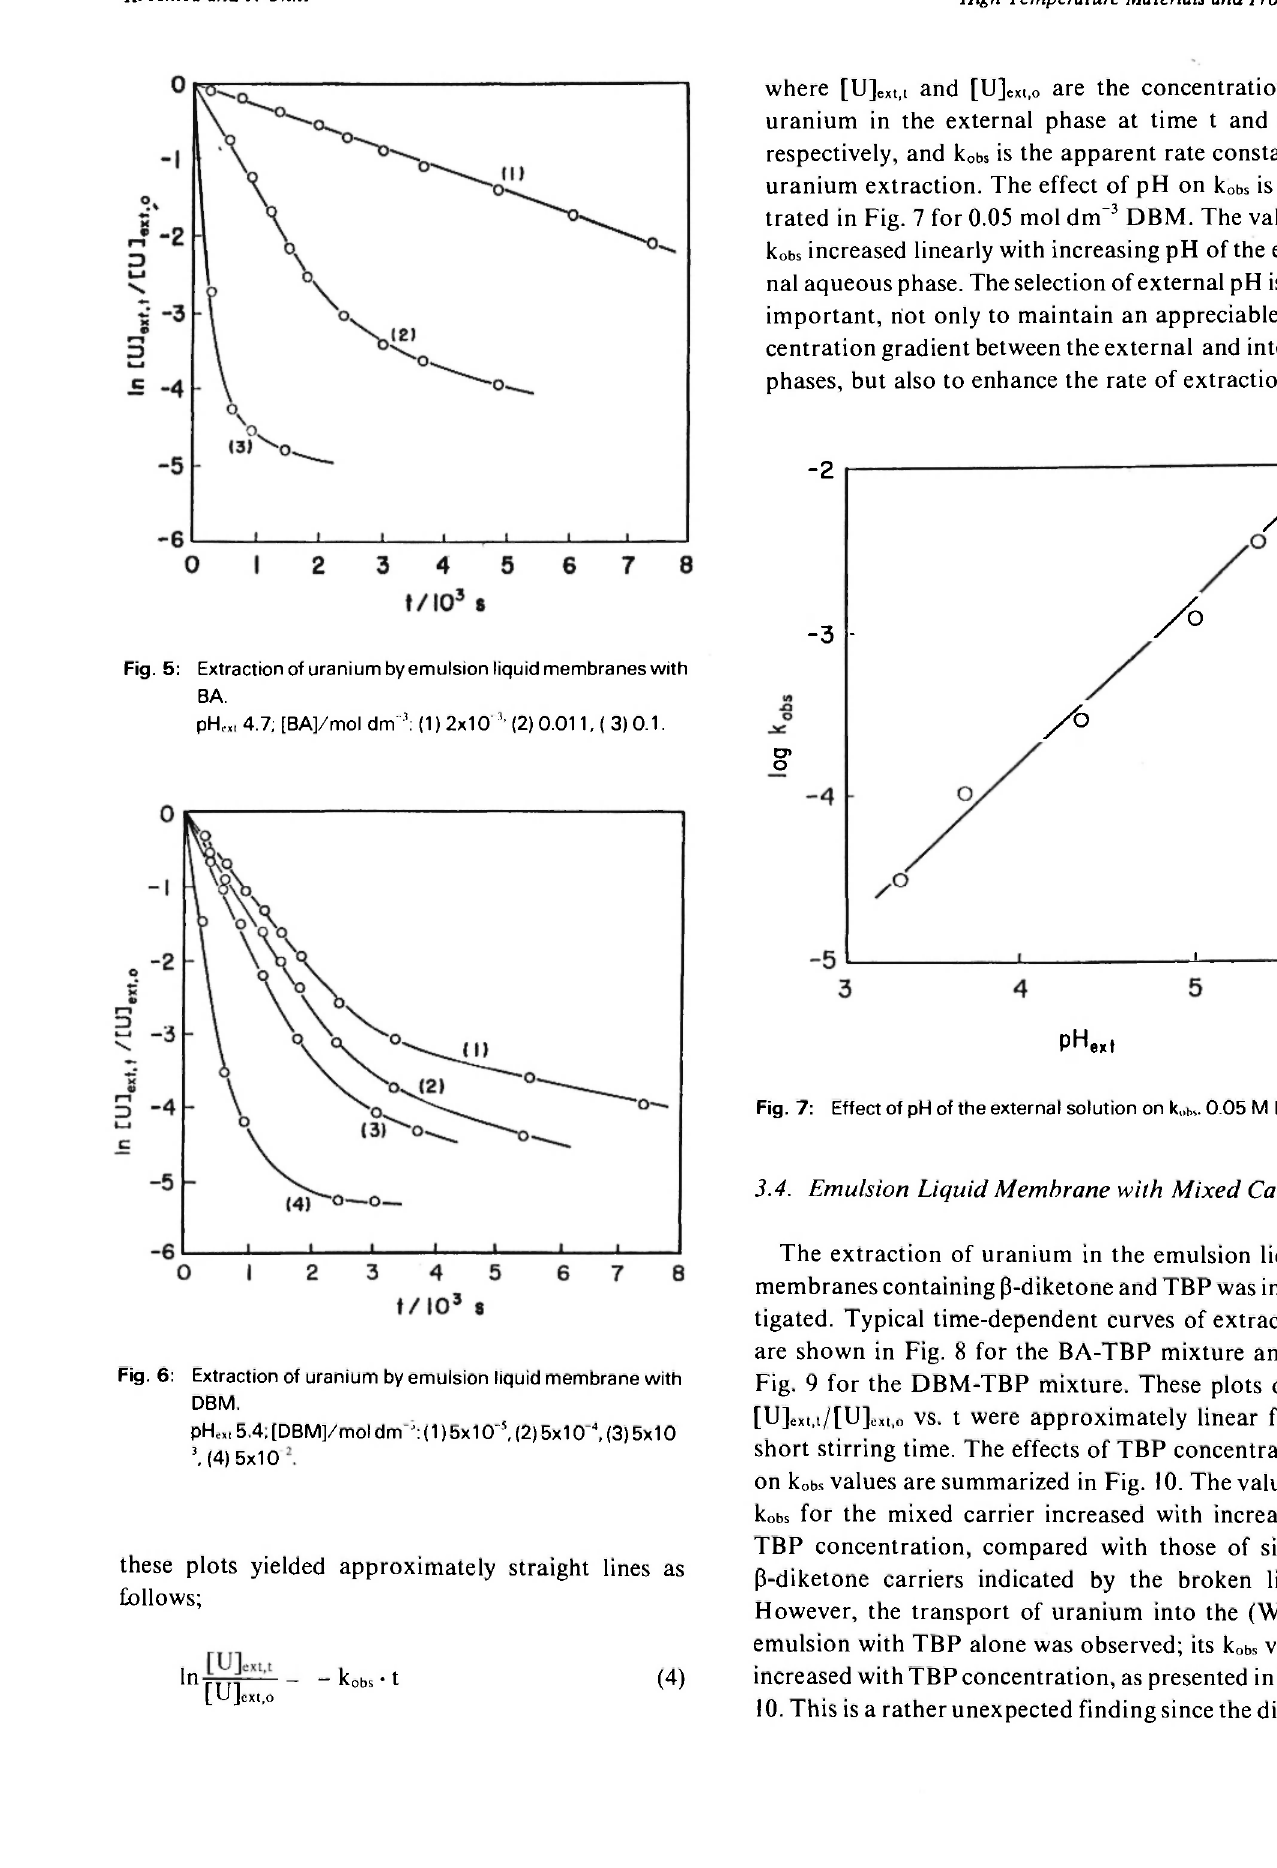
Fig. 6: Extraction of uranium by emulsion liquid membrane with DBM.